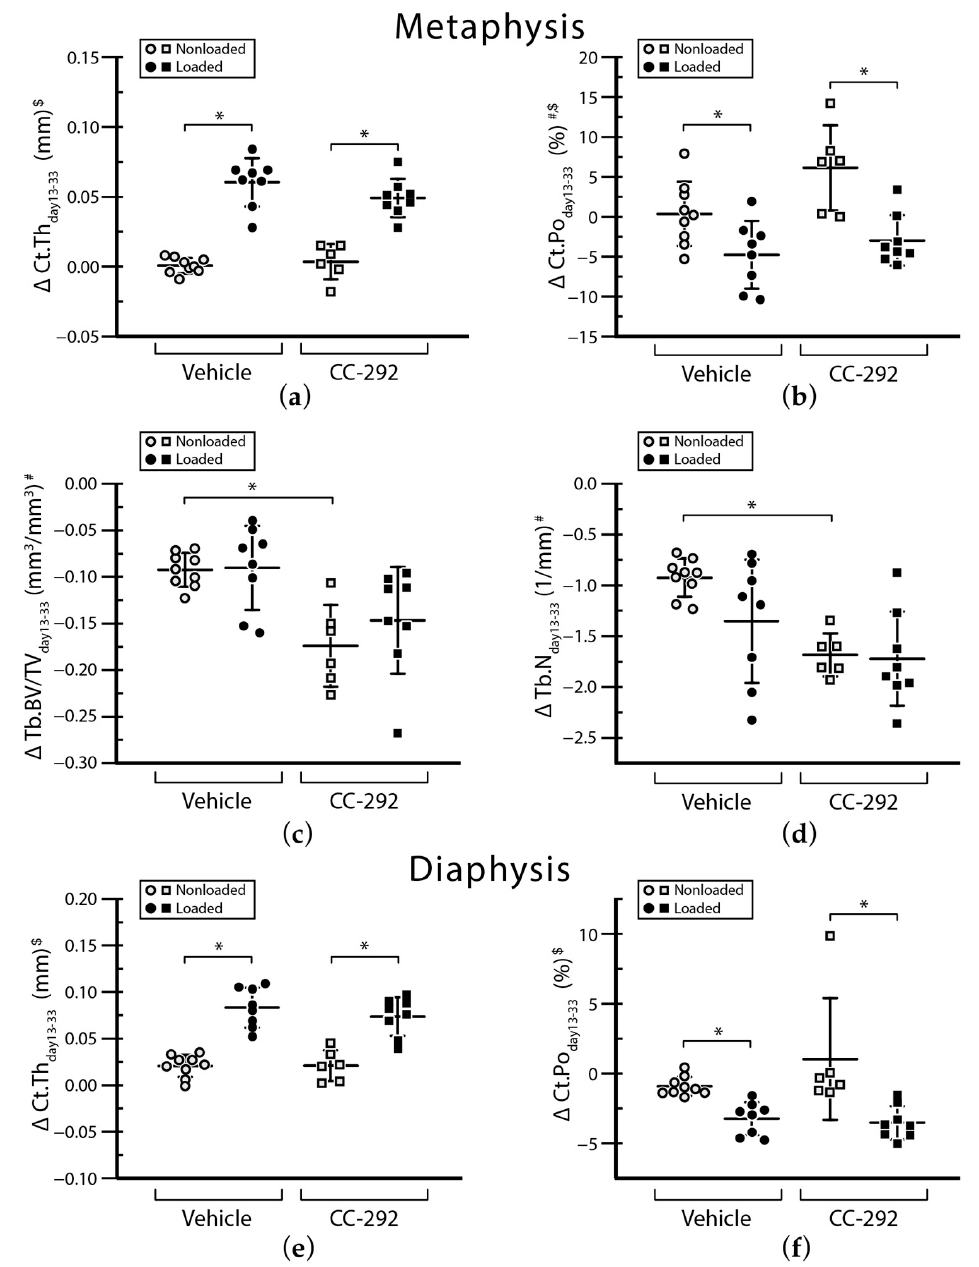
Figure 3. MicroCT parameters between day 13 and 33 of the experiment. The graphs depict cortical and trabecular microarchitectural parameters in the metaphysis and diaphysis. Shown are changes between day 13 and day 33 of ( a) metaphyseal cortical thickness, ( b ) metaphyseal cortical porosity, ( c ) trabecular bone volume fraction, ( d ) trabecular number, ( e ) diaphyseal cortical thickness, and ( f ) diaphyseal cortical porosity. Individual values are given together with mean ± SD. ANOVA main effects: (#) treatment, ($) loading, followed by Tukey–Kramer post-hoc test, * p < 0.05.